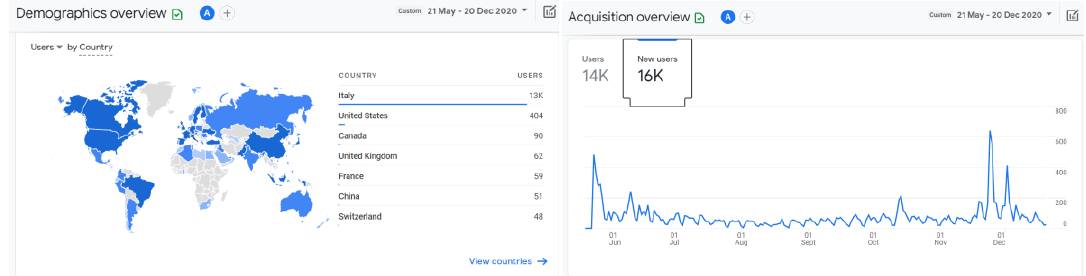
Figure 10. Statistics of the IdroGEO platform. On the left, users by countries, on the right, the number of new users. Source: Google Analytics.